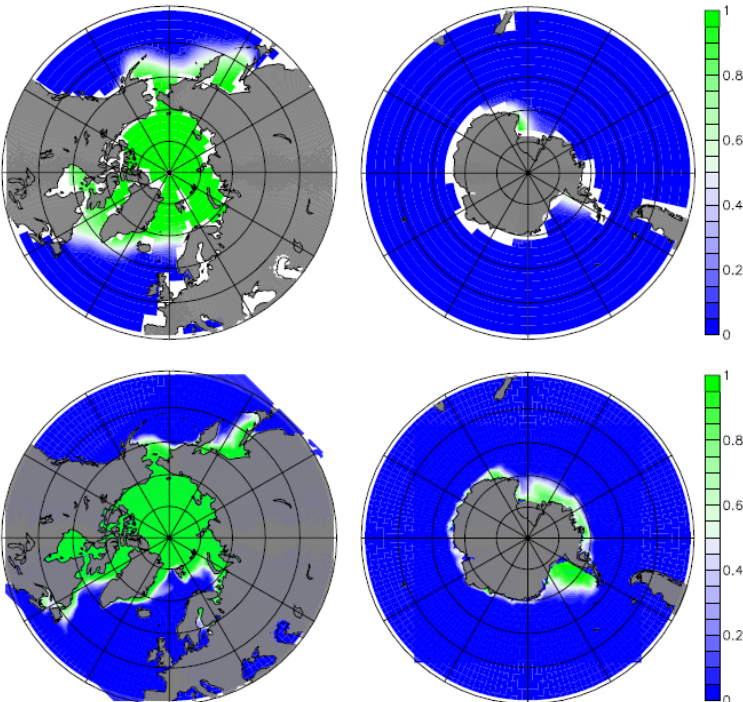
Fig. 12. The sea ice cover fraction in March in the Arctic (left) and the Antarctic (right). The top row shows the SPEEDO ensemble mean and bottom row the data from Cosimo (2008).